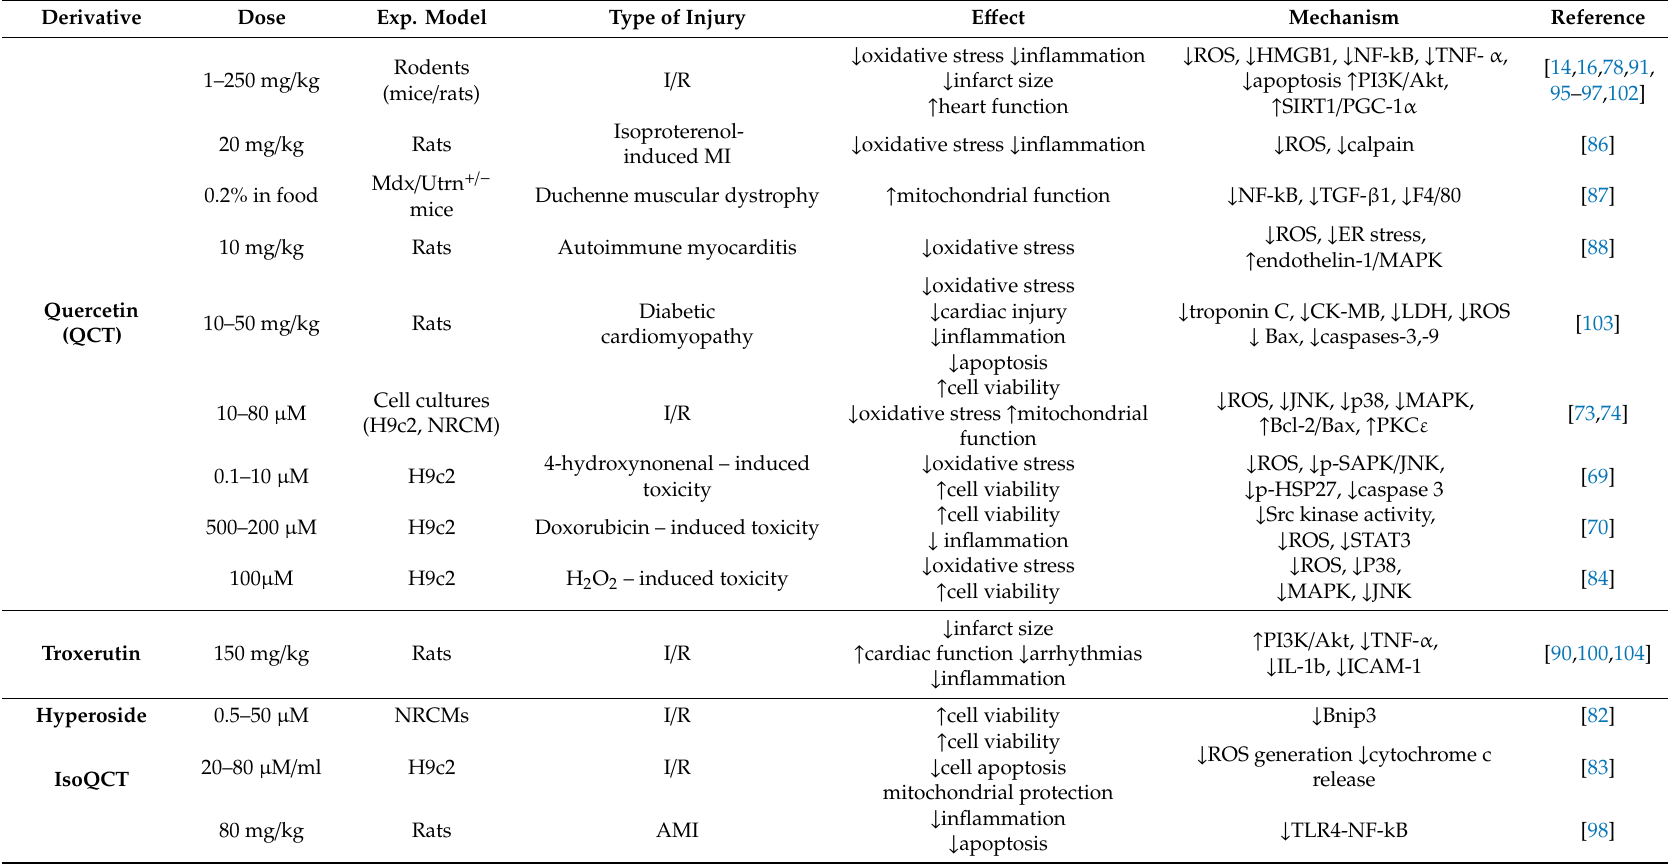
Table 2. Summary of potential cardioprotective e ff ects of QCT and its